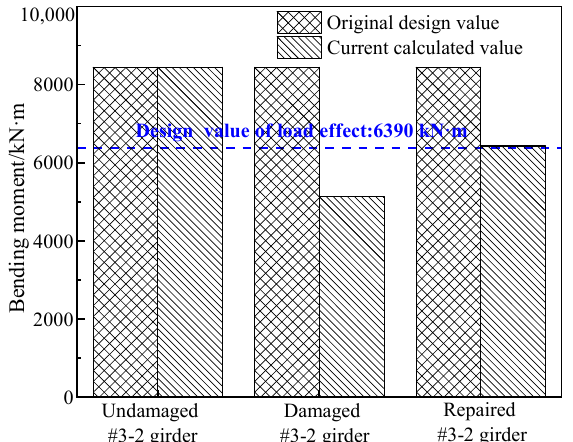
Figure 6. Comparison between the calculated fl exural capacities and the design load e ff ect value.